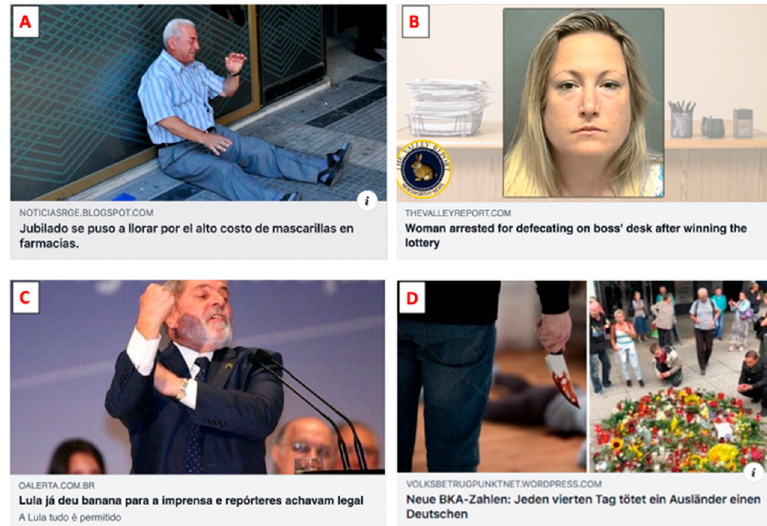
Figure 1. Four fake news items on social media in different countries verified by fact-checkers (Spain, United States, Brazil, Germany). Note: All images ( A – D ) were taken from fact-checking websites. Image A (‘Maldita.es’), image B (‘Snopes’), image C (‘Lupa’) and image D (‘Correctiv’). The addresses of sites are described in footnotes. 1